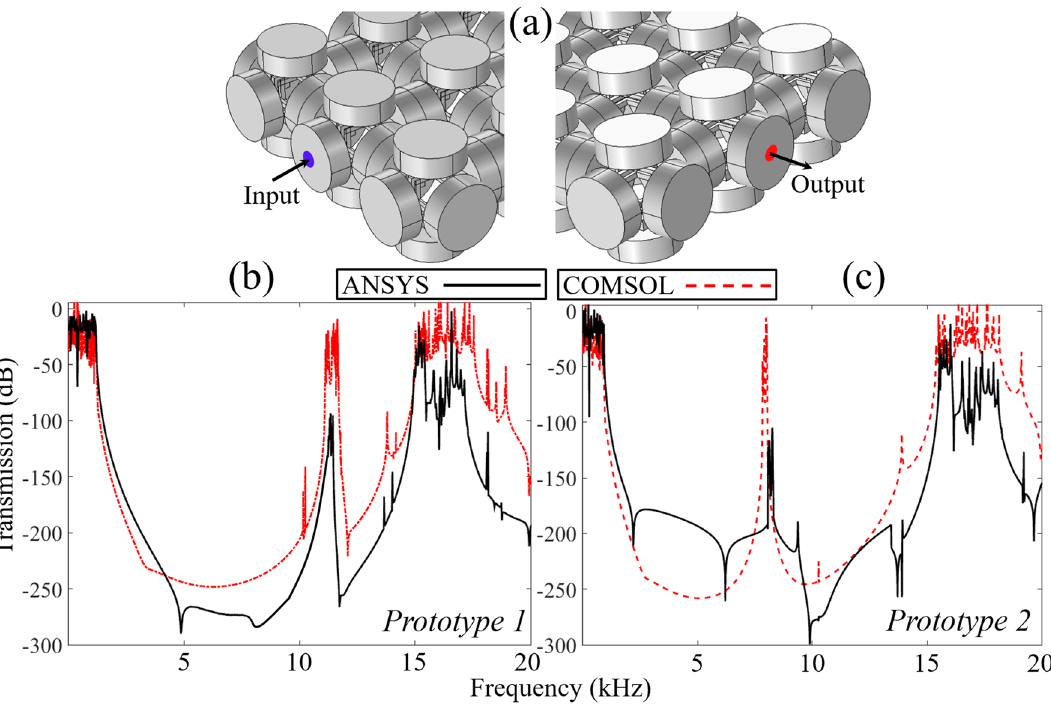
Figure 4. ( a ) Finite supercell with input (blue) and output (red) probes; ( b , c ) response spectrum for Prototype 1 and Prototype 2 obtained from COMSOL Multiphysics (red dashed line) and ANSYS workbench (black solid line).